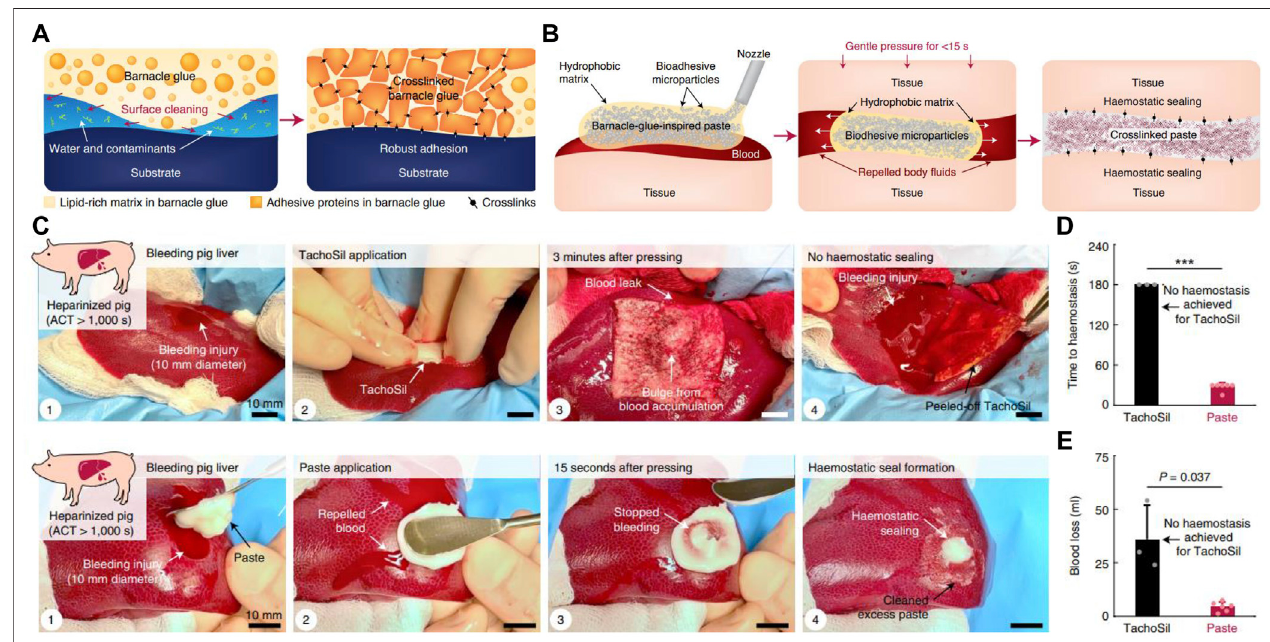
FIGURE 7 | Barnacle cement – inspired paste tissue adhesive. (A) Diagram of the adhesion process of barnacle cement. (B) Schematic diagram of the application andadhesionmechanismofthebarnacle-inspiredpastetissueadhesive. (C) Pastetissueadhesivesuccessfullypreventsbleedingintheinjuredliverofapigthatwasfully anticoagulated after systemic heparin administration [by intravenous heparin bolus to yield an activated clotting time (ACT) of more than 1,000 s], while the commercial productTachoSilfailed. (D) Timerequired forTachoSilandpastetostophemorrhage. (E) Finalbloodloss inhemostasisexperimentsperformedwithTachoSiland paste. Adapted from Yuk et al.